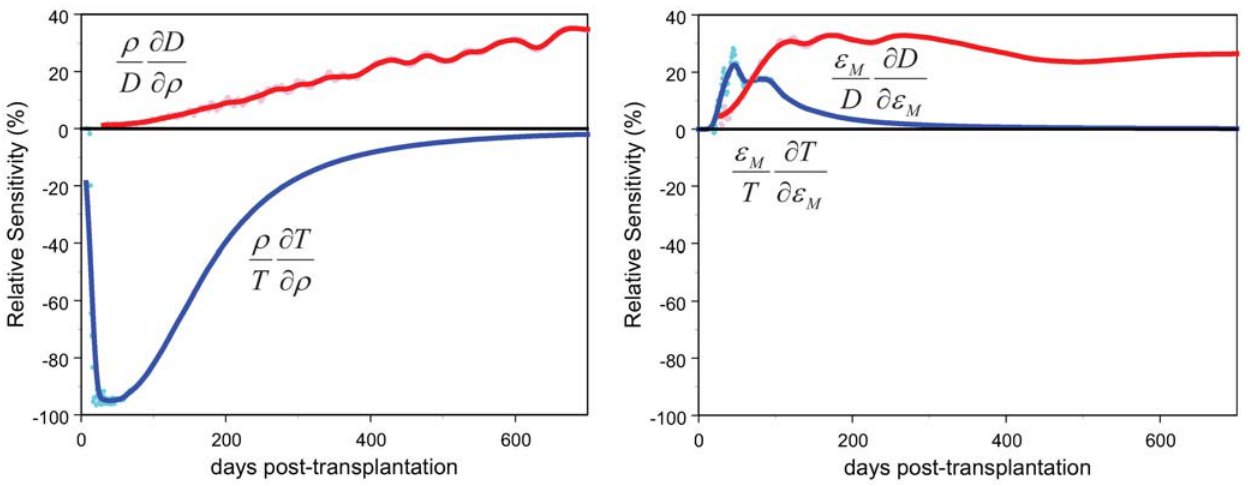
Figure 5. Sensitivity curves. Relative sensitivity trajectories for the model fit to data from subject 1. The left panel shows the relative sensitivity to changes in r ; the right panel shows the relative sensitivity to changes in e M , the maximum thymic emigration rate. Blue curves give the model solutions for c 0 + h T ; red curves give the model solutions for the (unbiased) TCR repertoire diversity.